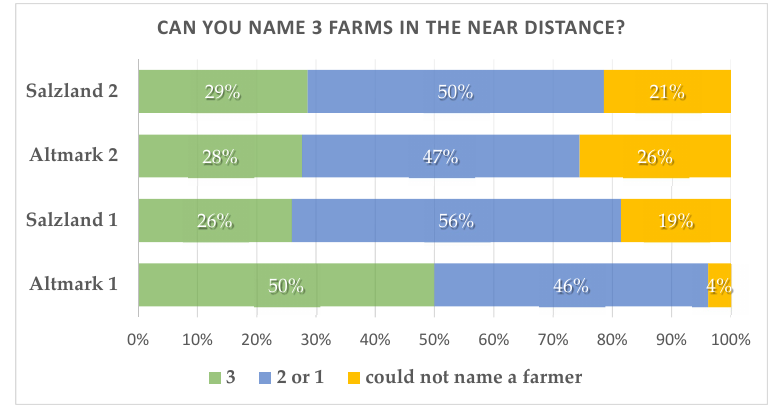
Figure 3. Please name up to three farmers in the near